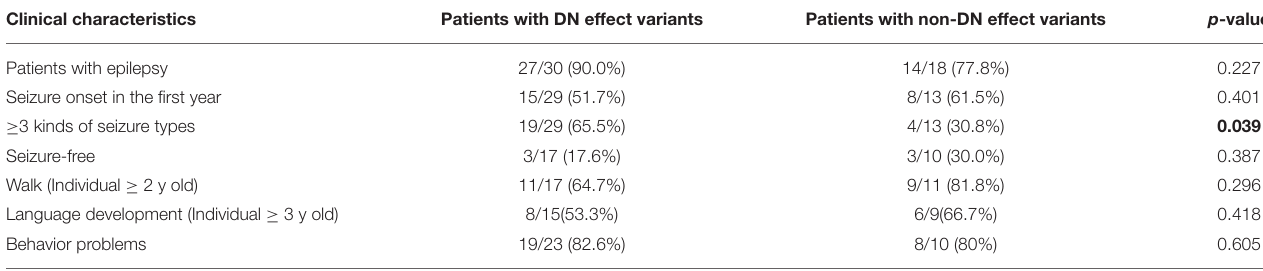
TABLE 3 | Comparisons of patients with DN and non-DN effect KCNB1 variants in clinical